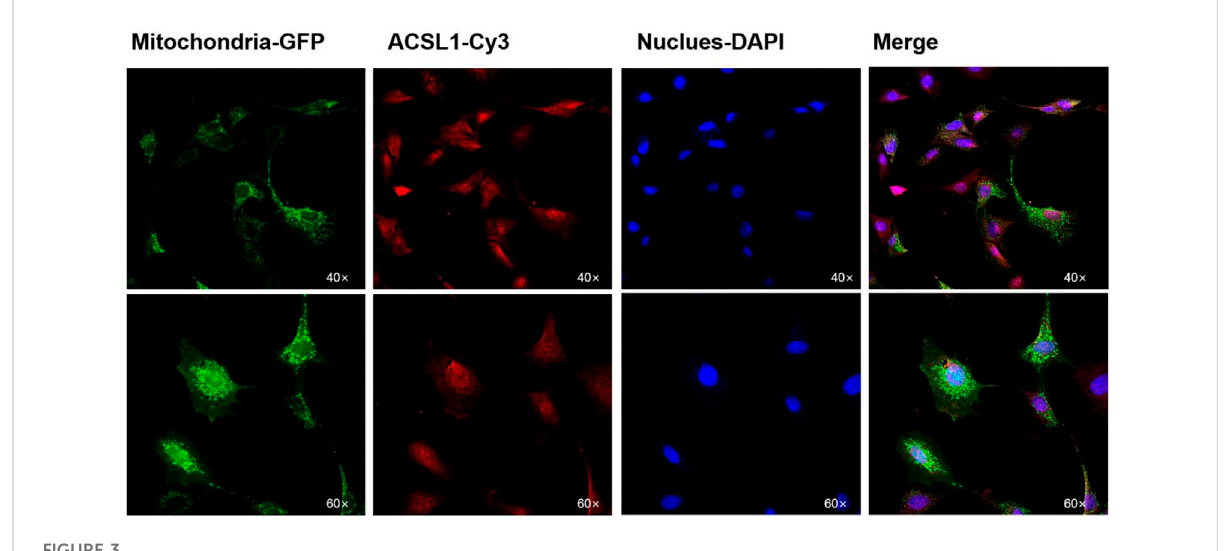
FIGURE 3 Subcellular localization of ACSL1 in sheep